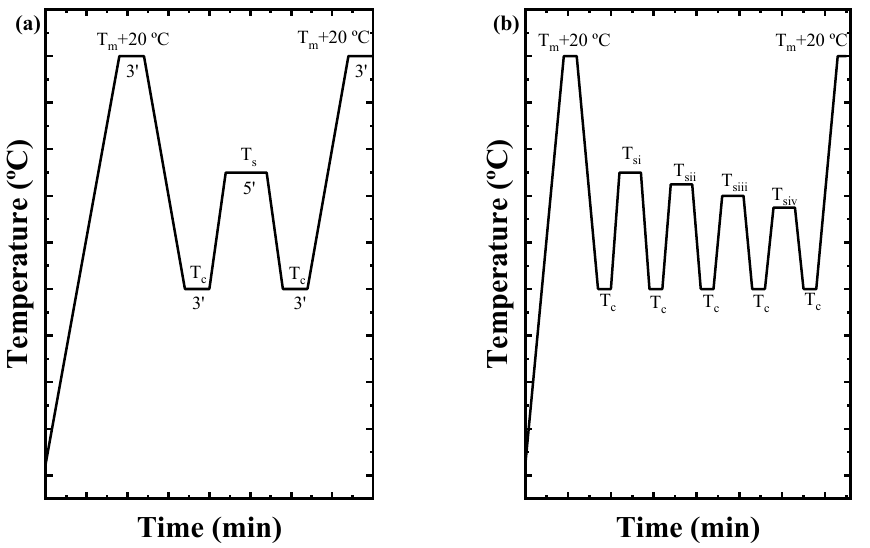
Figure 13. Scheme of all the steps necessary to perform the ( a ) self-nucleation (SN) protocol and ( b ) the SSA thermal fractionation.